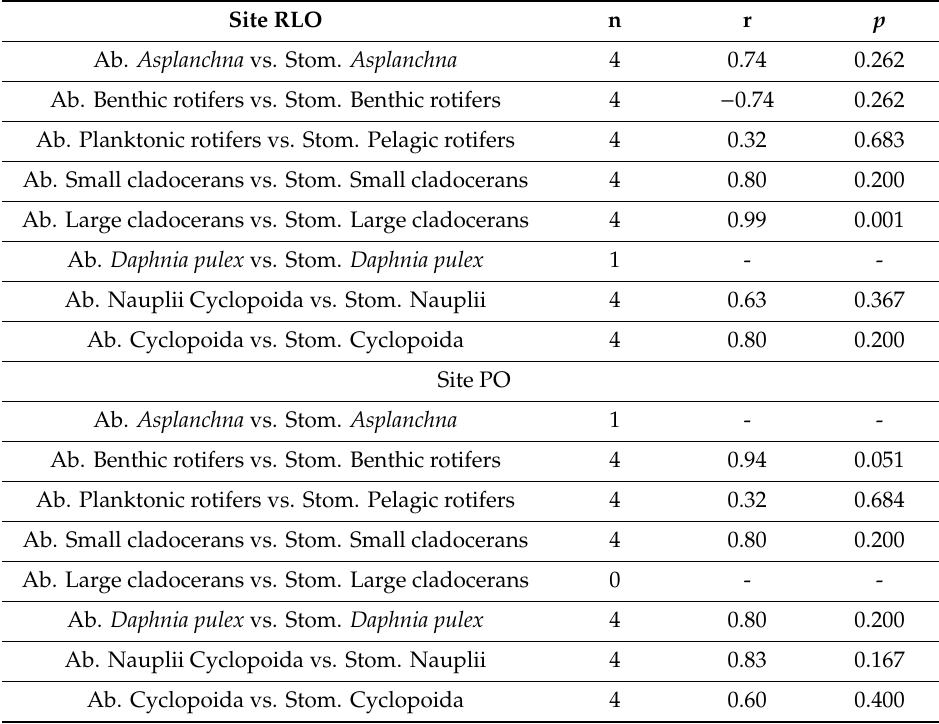
Table 5. Spearman correlations between zooplankton group abundance in RLO and PO sites versus number of zooplankton in fish stomachs ( p < 0.05). Ab.—abundance in water, Stom.—number in stomach. Significant results are marked in